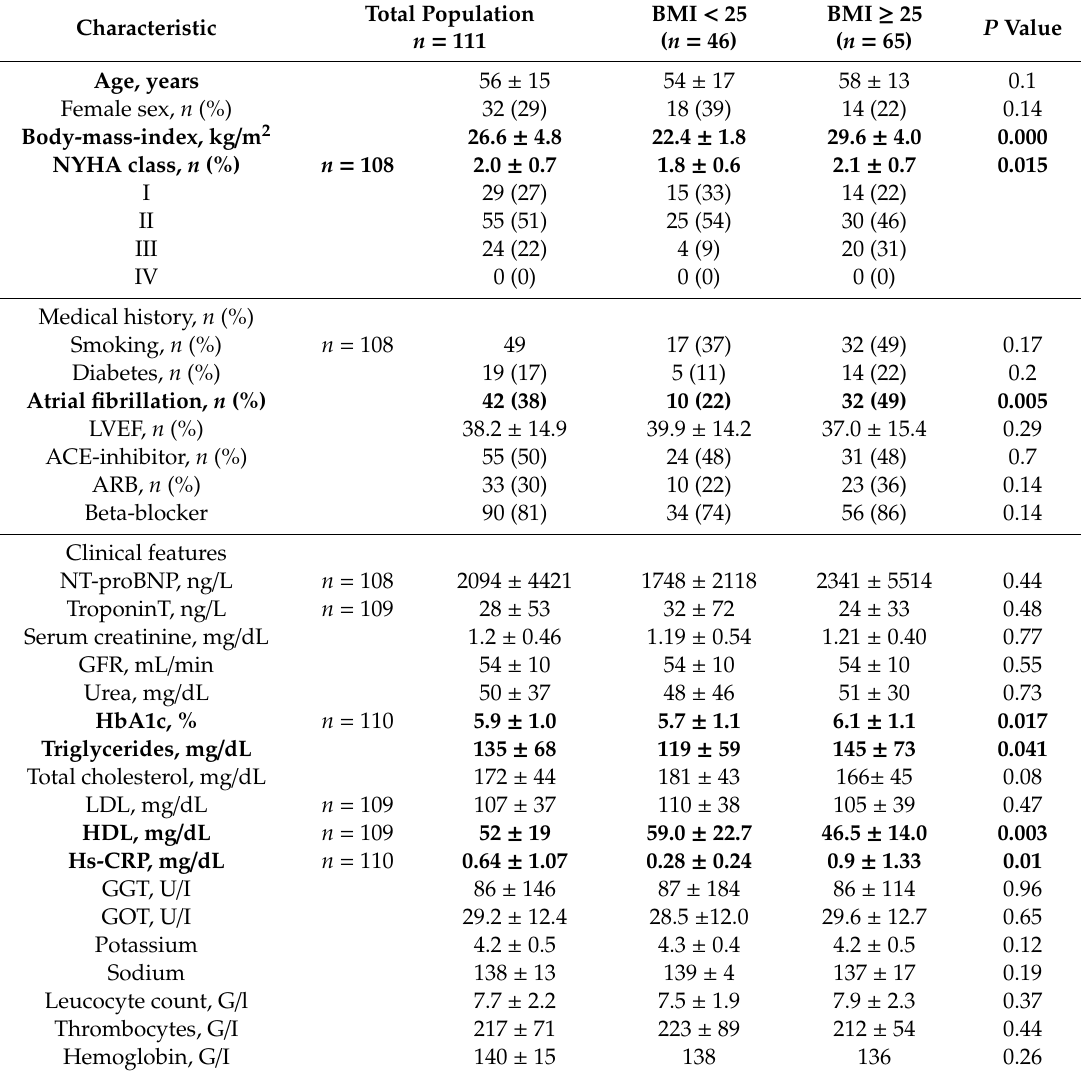
Table 1. Characteristics of Patients at